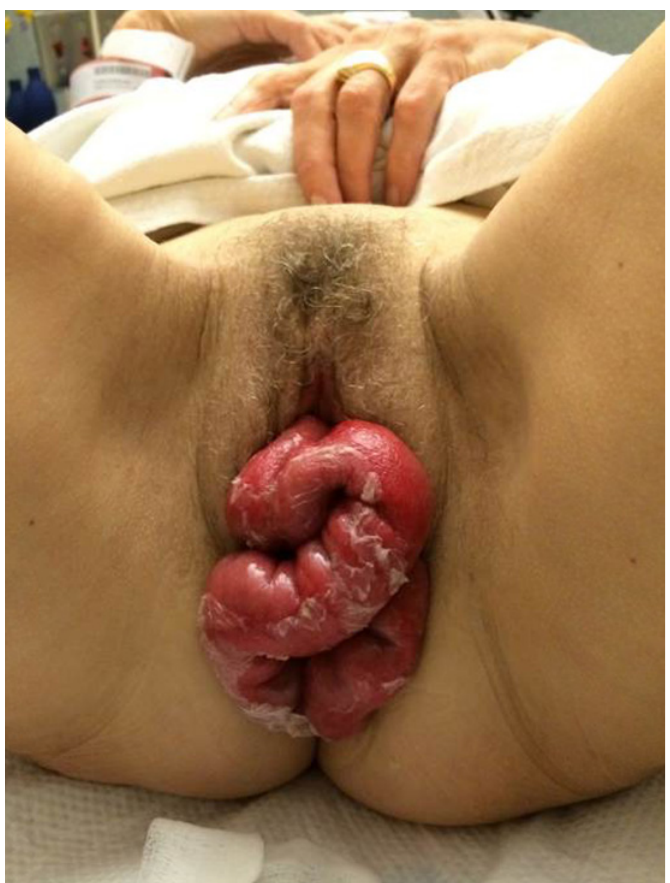
Figure. Intestinal tissue erythematous, edematous, non-necrotic and visibly peristalsing on